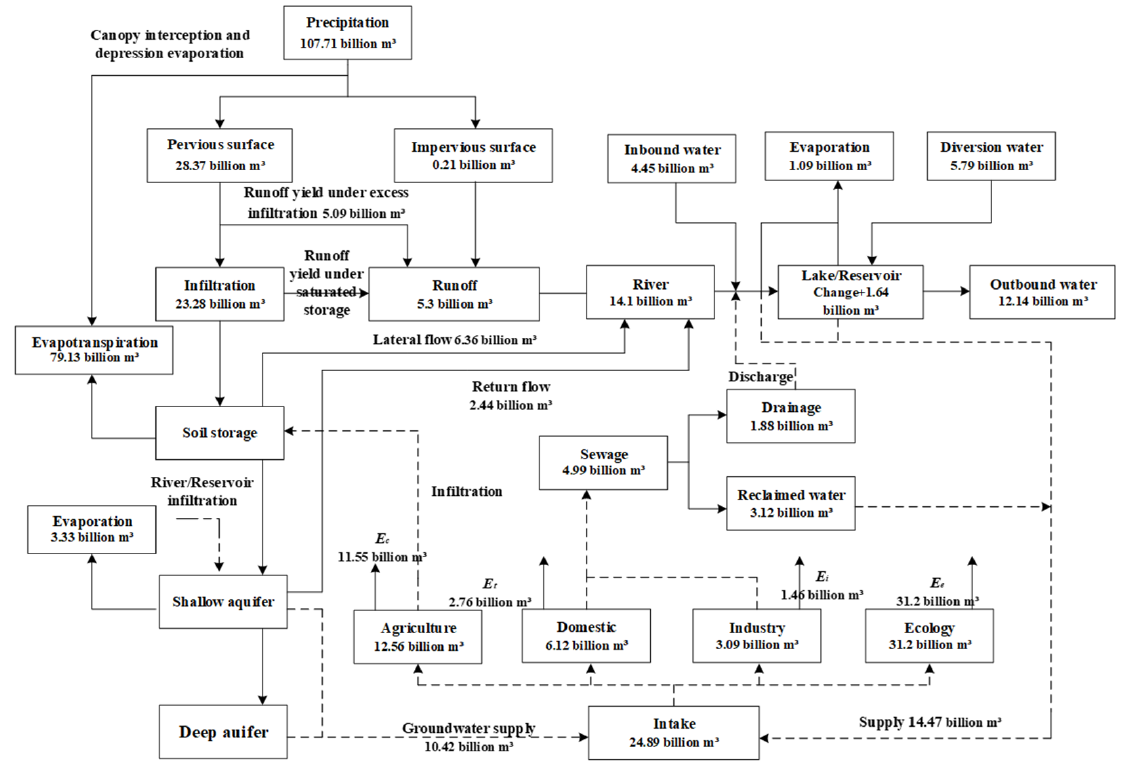
Figure 9. Natural and social water cycle transformation process.